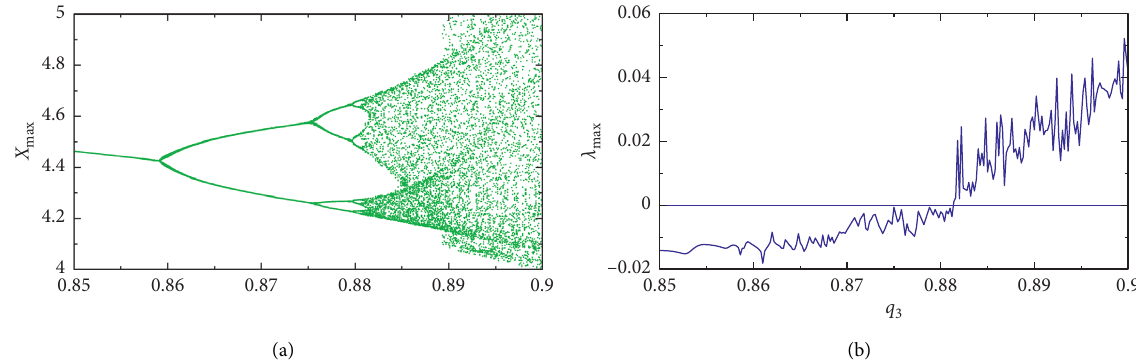
Figure 8: Bifurcation diagram and largest Lyapunov exponent ( λ Lyapunov exponent ( λ